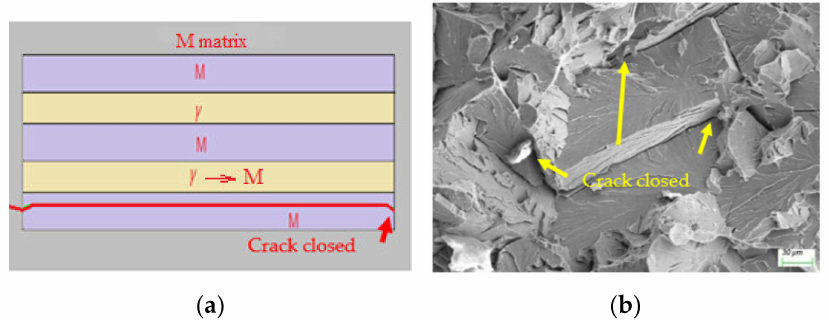
Figure 11. Morphology induced by thin-film MA: ( a ) numerical simulation; and ( b ) the corresponding experimental